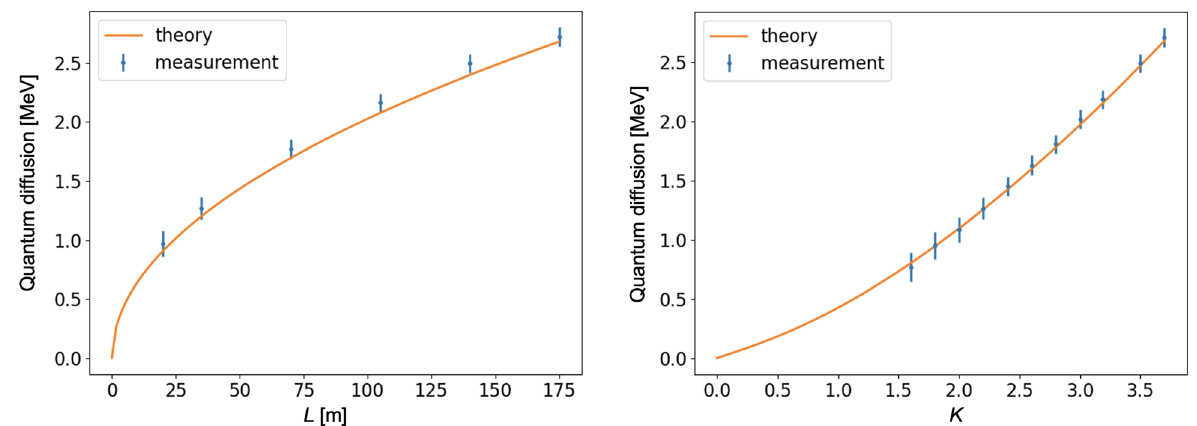
Figure 3. Left plot shows the quantum diffusion as a function of the magnetic length of the undulator for K = 3.7 . Right picture shows the quantum diffusion as a function of the undulator deflection parameter K of the undulator with magnetic length of 175